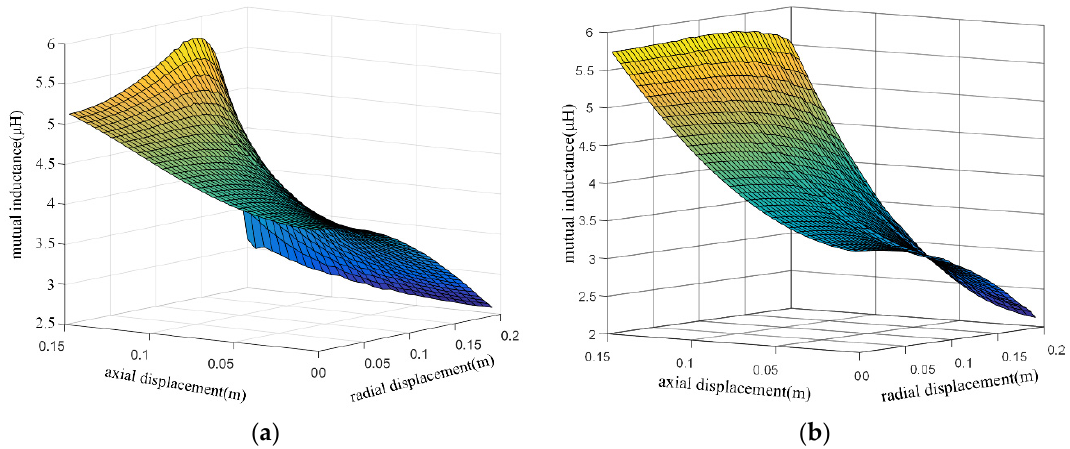
Figure 4. Mutual inductance when the receiving coil is in axial and radial displacement without directional misalignment from: ( a ) Calculation; ( b ) measurement.